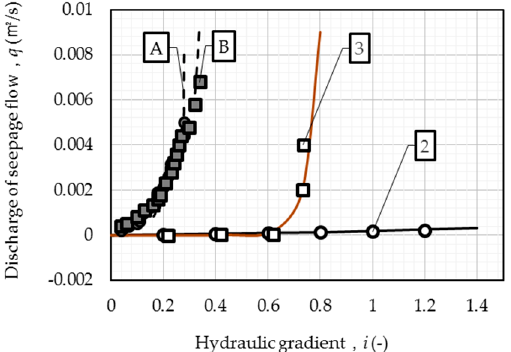
Figure 8. Calibration: dashed lines for computation results of runs in Skempton and Brogan [9]; solid lines for computation results of runs in Wan and Fell [1]; Solid points for test results of runs in Skempton and Brogan [9]; and hollow points for runs in Wan and Fell [1].